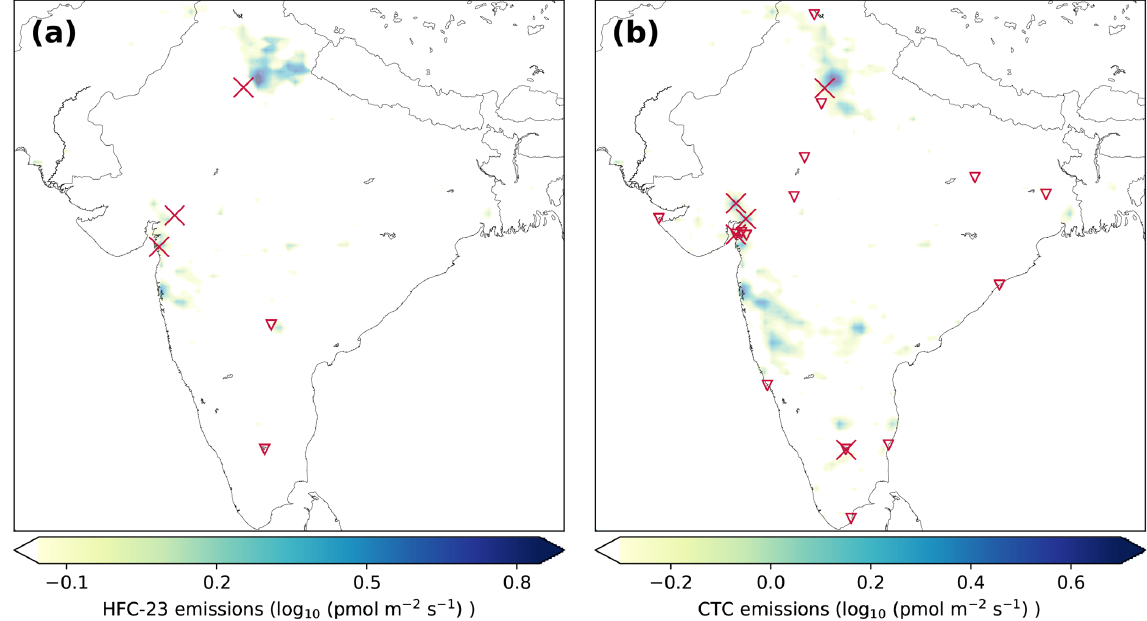
Figure 6. (a) Posterior emissions map for HFC-23 (pmolm − 2 ) s − 1 . The known locations of major ( > 8Ggyr − 1 ) and minor ( < 1.5Ggyr − 1 ) manufacturers of HCFC-22 are represented by the crosses and open triangles respectively. (b) Posterior emissions map for CTC (pmolm − 2 s − 1 ). The known locations of chloromethane production facilities (crosses) and chlor-alkali plants (open triangles) are also